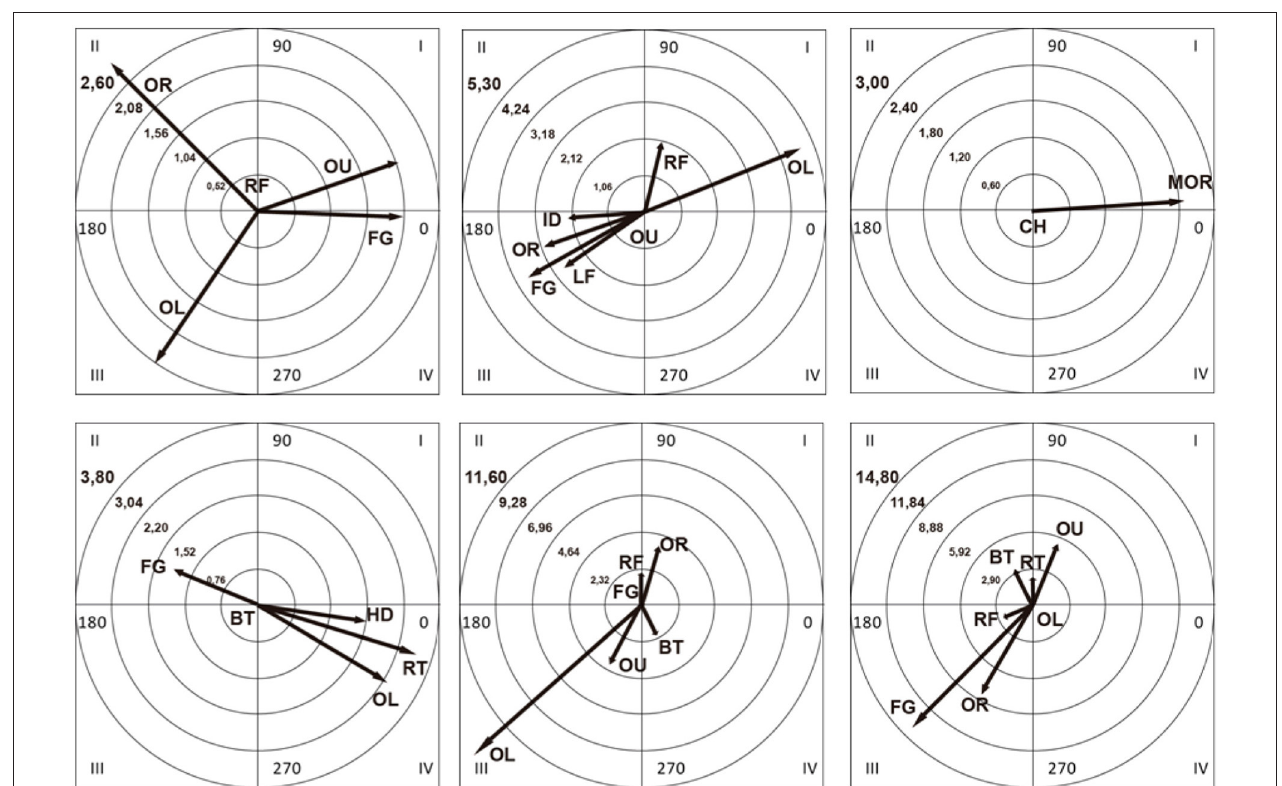
FIGURE 3 | Polar coordinate maps 1–6 (read from left to right and top to bottom).